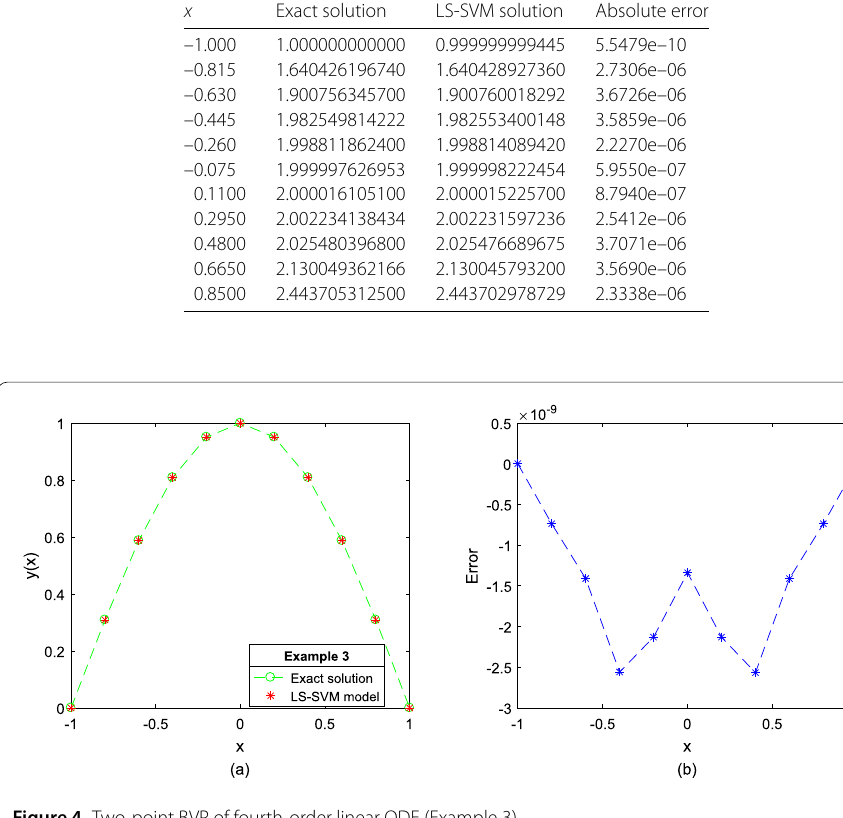
Figure 4 Two-point BVP of fourth-order linear ODE (Example